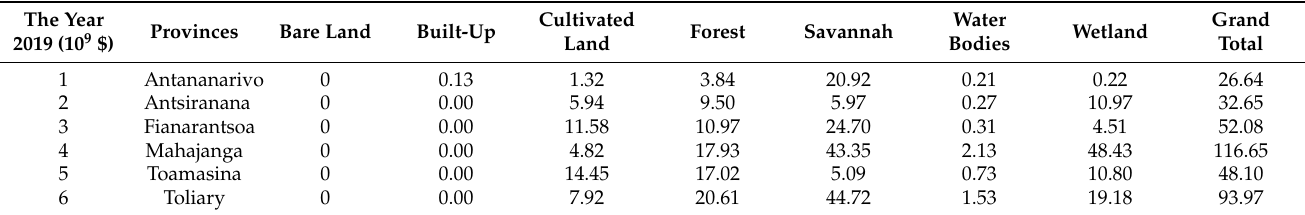
Table 5. Madagascar’s Ecosystem services value (ESV) by land-use type and changes in